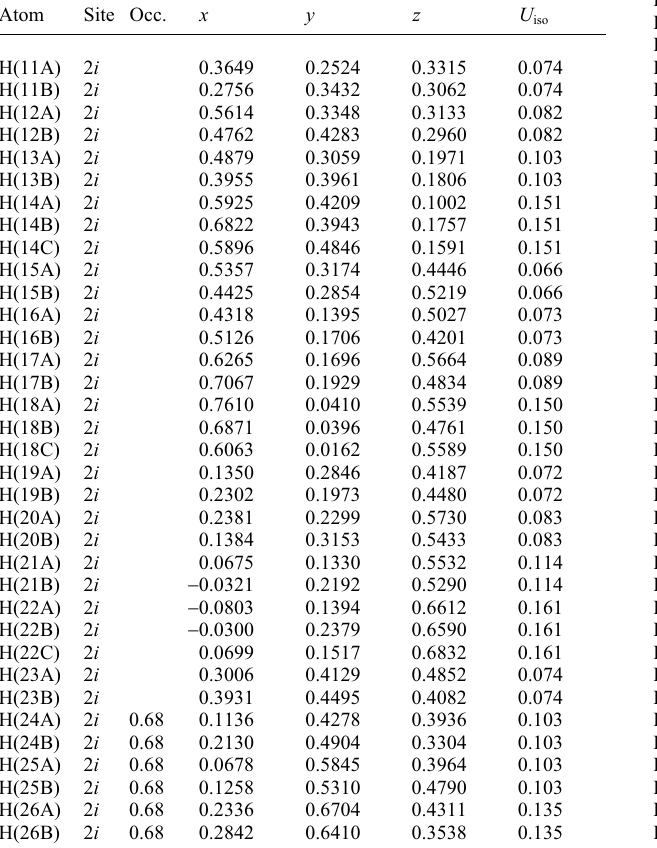
Table 2. Atomic coordinates and displacement parameters (in Å 2 ) .